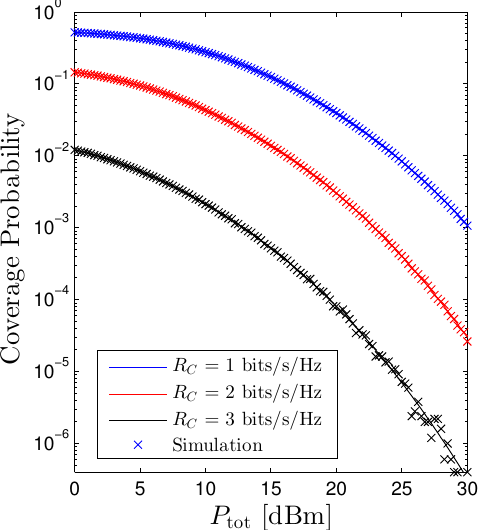
Figure 6. Coverage probability vs. P tot under the random scheme. Solid lines are plotted by employing (21) and markers are Monte Carlo